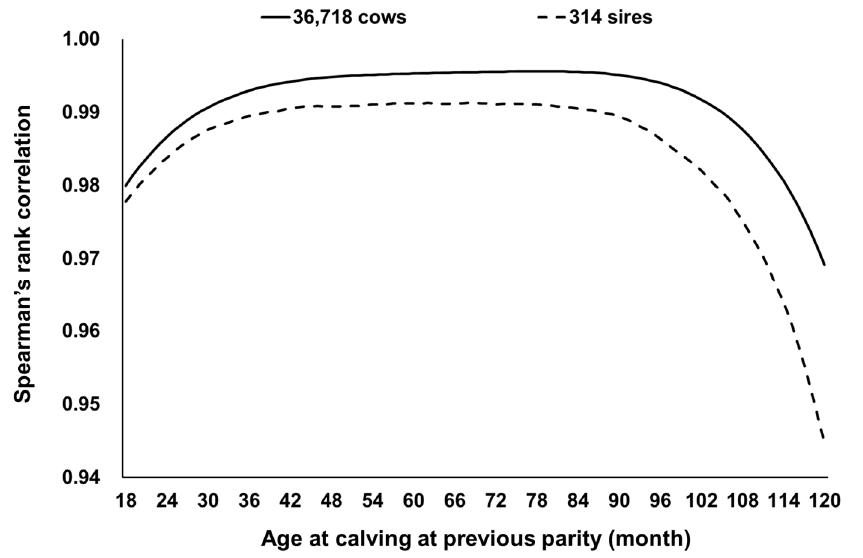
Figure 4. Spearman’s rank correlation between estimated breeding values obtained by the random regression model and repeatability model for 36,178 cows with their own calving interval records and 314 sires of the 36,178 cows.